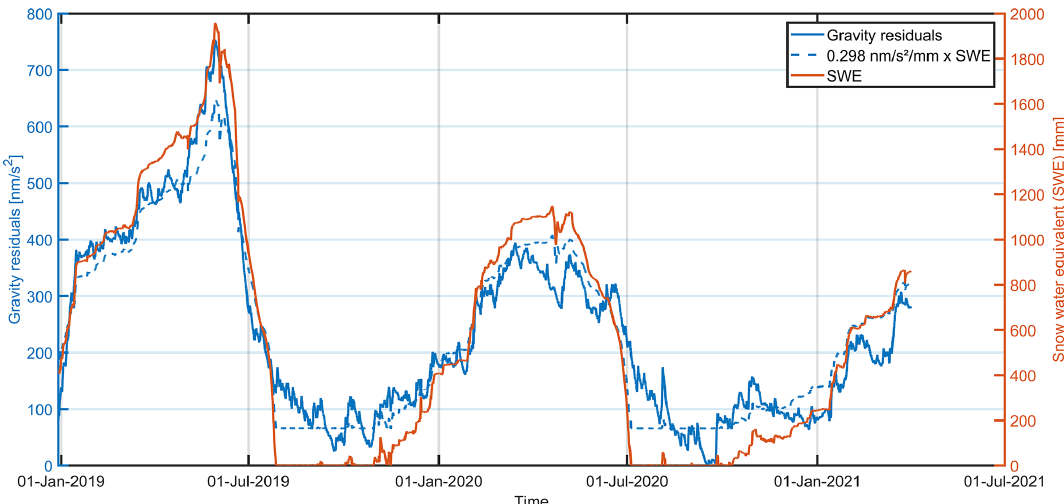
Figure 4. Gravity residuals (solid blue), snow water equivalent (solid red) from LWD station at Zugspitzplatt and SWE multiplied with the estimated regression factor of 0.298nms − 2 mm − 1 between gravity residuals and snow water equivalent (dashed blue